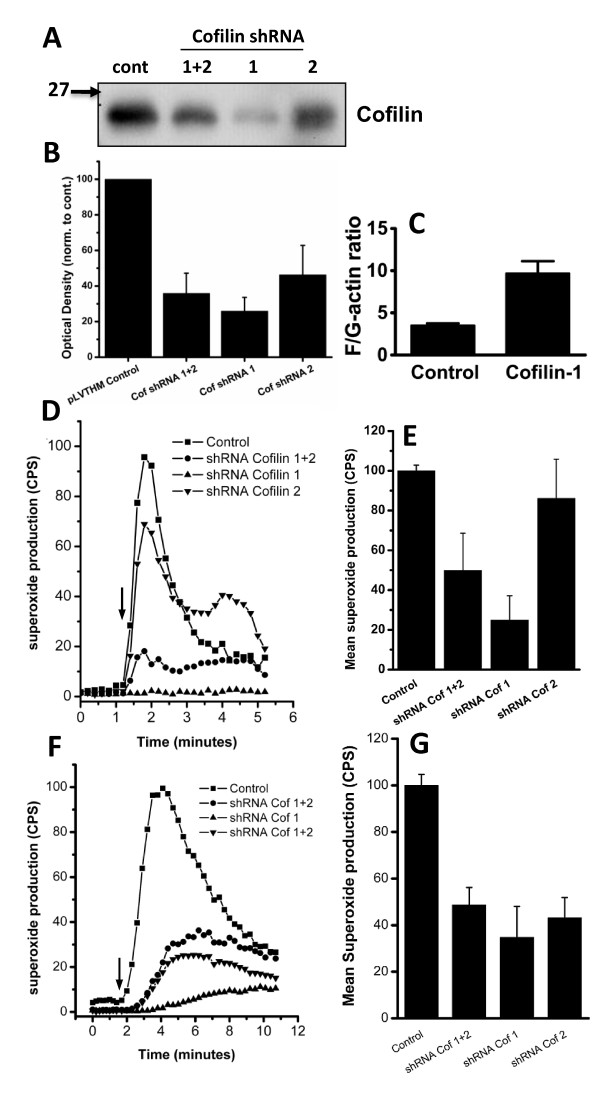
Cofilin knock-down increases F/G-actin ratio and inhibits superoxide production. A and B) Levels of cofilin protein after tetracycline induction of two different cofilin shRNAs alone or in combination was determined by western blotting. Control cells refer to Ra2 cells transduced with empty pLVTHM dsRed vector. The bar graphs in B shows mean optical density and SEM of western blot bands derived from three independent experiments. C) Ratio of F- to G-actin in control and cofilin-1 shRNA-expressing Ra2 cells. Data represent mean ± SEM of two independent experiments, each performed in triplicate. D-G) Superoxide production in control or cofilin shRNA-transduced Ra2 cells before and after stimulation with FMLP (D,E) or PMA (F,G) was measured by luminol E-CL. The ordinate of the trace graphs show luminol E-CL normalized to control cells in arbitrary units. Injection of agonist is indicated by arrow. Bar graphs E and G) show normalized luminol E-CL mean and SEM of three independent experiments as performed in A or C, respectively.